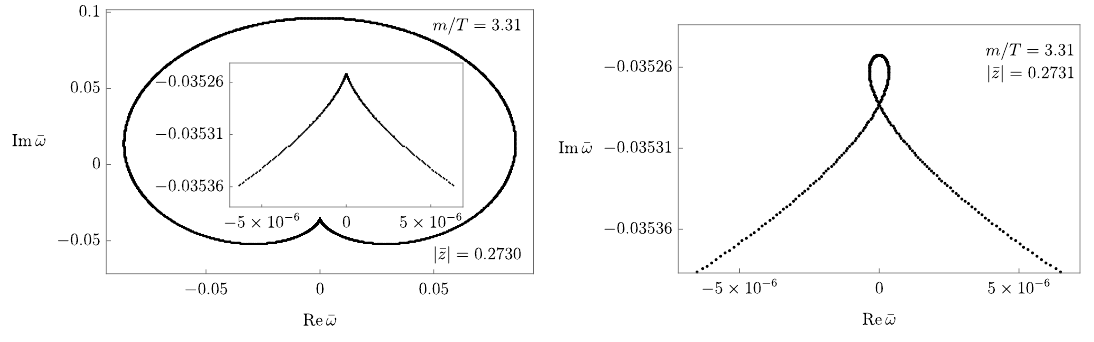
Figure 8 . The formation of a cusp and eventual self-intersection for the transverse sound mode in Case I T at m/T = 3 . 31 . Here, the cusp of the curve ω ( z ) forms inside the convergence disk at | ¯ z | = 0 . 27 < ¯ R s = 1 . 16 . See appendix C. The inlay in the left panel shows the zoomed-in version of the